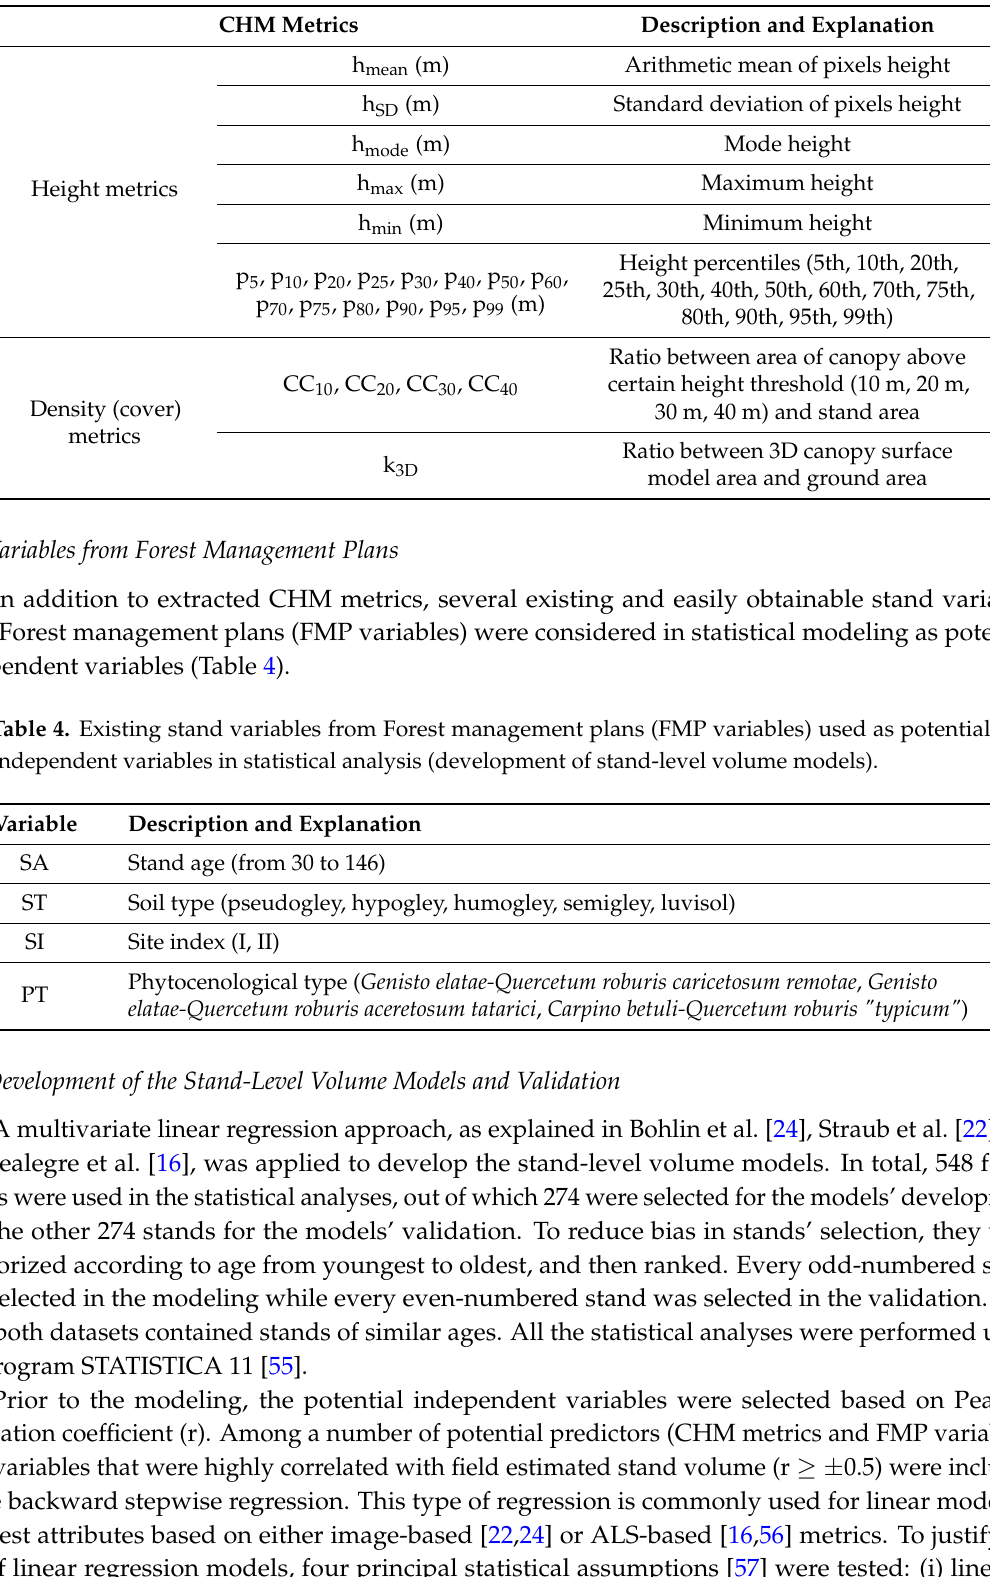
Table 3. Metrics extracted from CHMs, calculated for each stand and used as potential independent variables in statistical analysis (development of stand-level volume model).